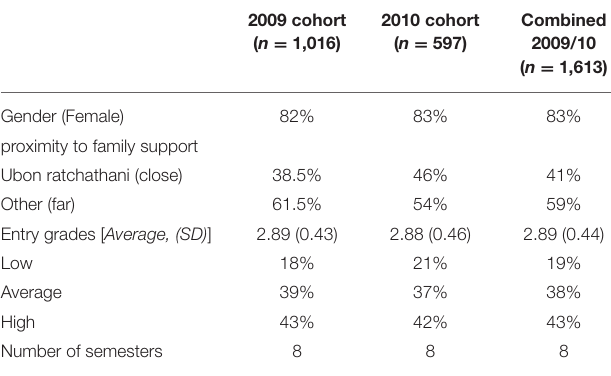
TABLE 1 | Descriptive statistics covering key background